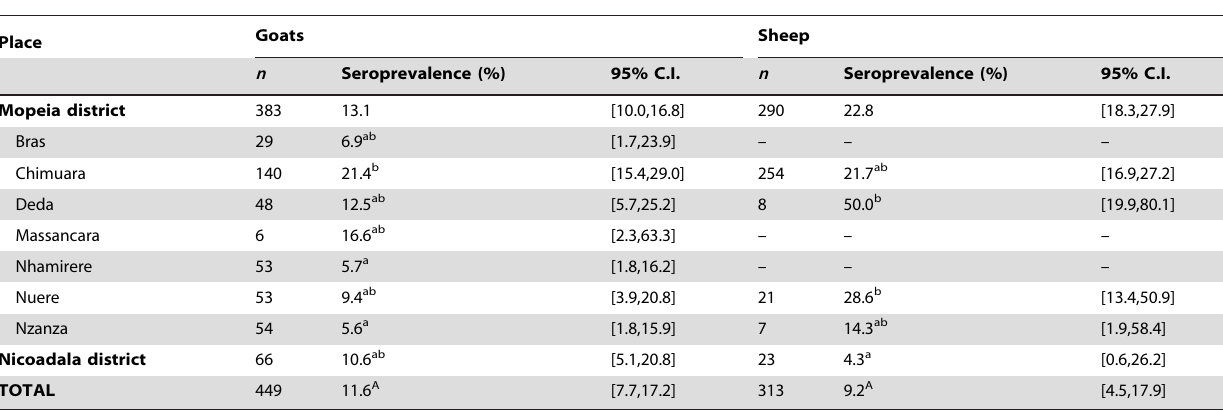
Table 2. RVF seroprevalence in 2010, as determined by IgG ELISA.